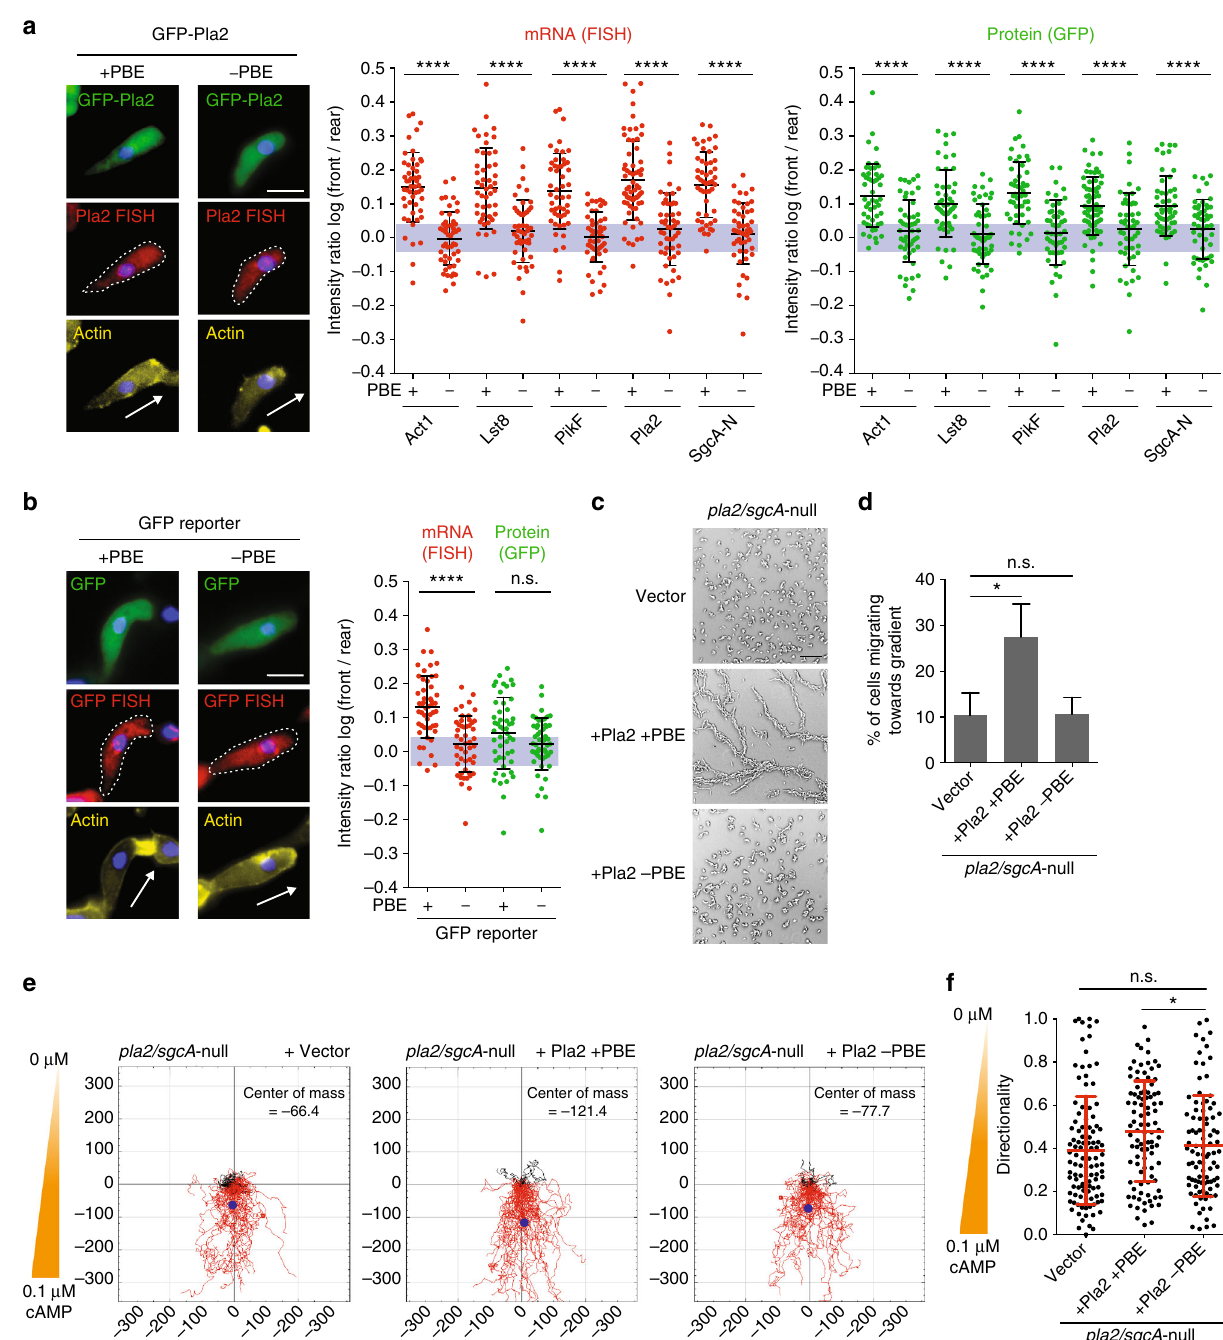
Fig. 3 The PBE of chemotaxis pathway mRNAs is required for mRNA and protein localization to the cell front and for chemotaxis. a Localization and quanti fi ed log F/R of GFP-tagged chemotaxis pathway proteins and corresponding mRNAs in cells in natural chemotactic streams. Genes were fused to their endogenous 3 ′ -UTRs with wild-type (+) or mutated ( − ) PBE. Arrow indicates orientation of cell polarity de fi ned by F-actin stain (Alexa Fluor 647- conjugated Phalloidin). DNA (nucleus) was stained with DAPI. The gray area indicates values equivalent to symmetric localization (between log(0.9) and log(1.1)). b Same quanti fi cation as in a on cells expressing a GFP reporter construct fused to Pla2 3 ′ -UTR ( ± PBE). For a and b : mean and SD, n ≥ 50 cells; Mann – Whitney test: **** p < 0.0001; scale bar, 10 μ m. c Chemotactic streams of pla2/sgcA -null cells expressing vector control, Pla2 +PBE or Pla2 -PBE after starvation for 15 h. Scale bar, 300 μ m. d Percent of pla2/sgcA -null cells expressing vector control, Pla2 +PBE or Pla2 -PBE migrating in a chemotaxis chamber for 180 min towards a 0.1 µ M/mm cAMP gradient (see also Supplementary Fig. 7C). Mann – Whitney test: * p < 0.05, n.s. not signi fi cant. e Tracks of individual migrating pla2/sgcA -null cells expressing vector control, Pla2 +PBE or Pla2 -PBE projected into the same starting point, and center of mass for all cells (blue dot); n ≥ 95 cells from ≥ 3 independent experiments. f Quanti fi cation of the directionality of cells in e . Mean and SD; Mann – Whitney test: **** p < 0.0001, n.s. not signi fi